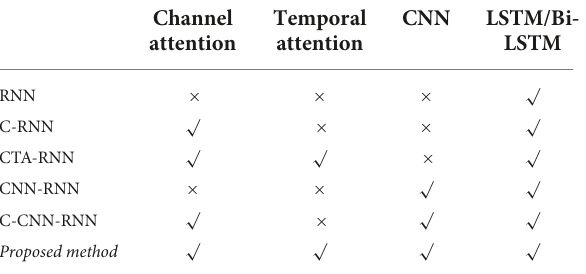
TABLE 5 Baseline and proposed method for EEG dataset emotion